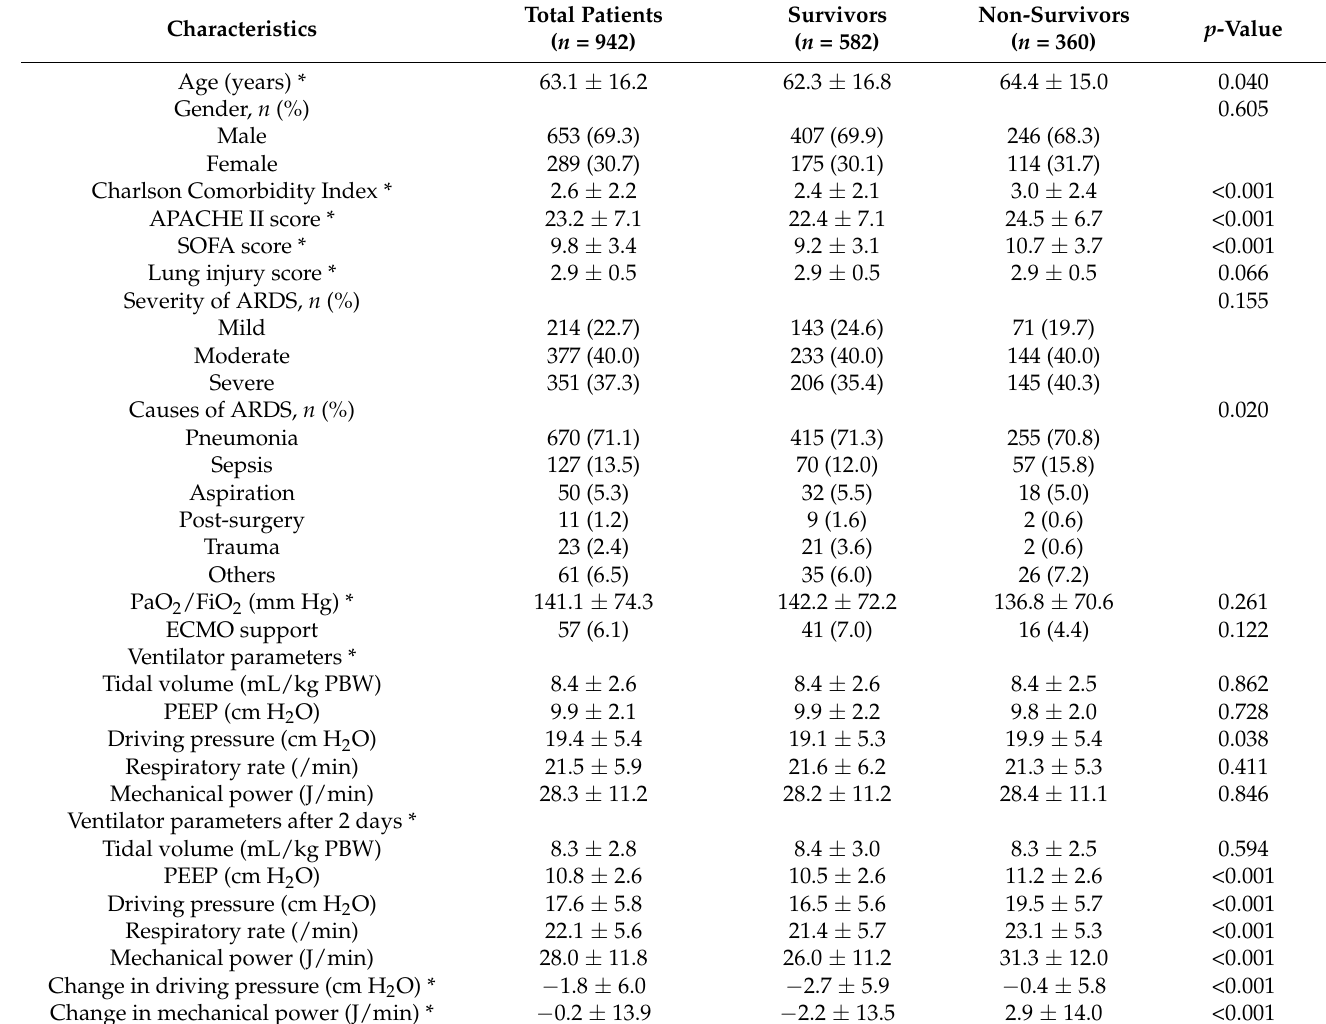
Table 1. Baseline clinical characteristics and ventilator parameters in patients with ARDS and comparison of these parameters between survivors and